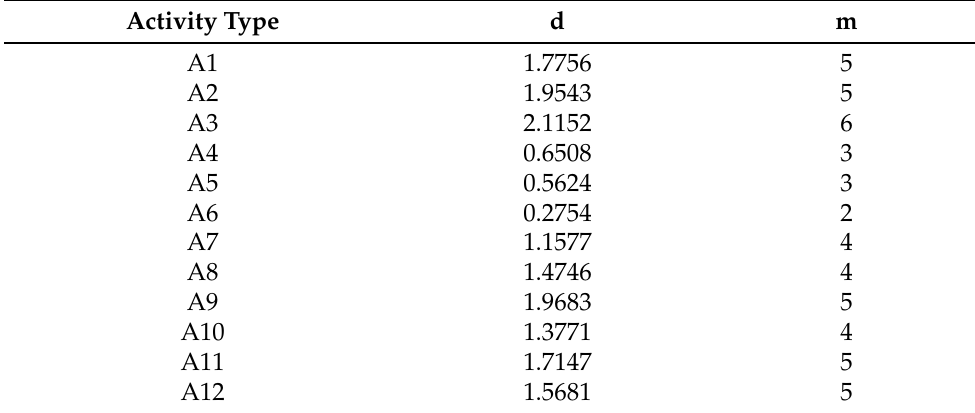
Figure 4. The ∆ S distribution by C-C method. ( a ) A1–A3; ( b ) A4–A6; ( c ) A7–A9; and, ( d ) A10–A12. Table 1. The correlation dimension and embedding dimension of all